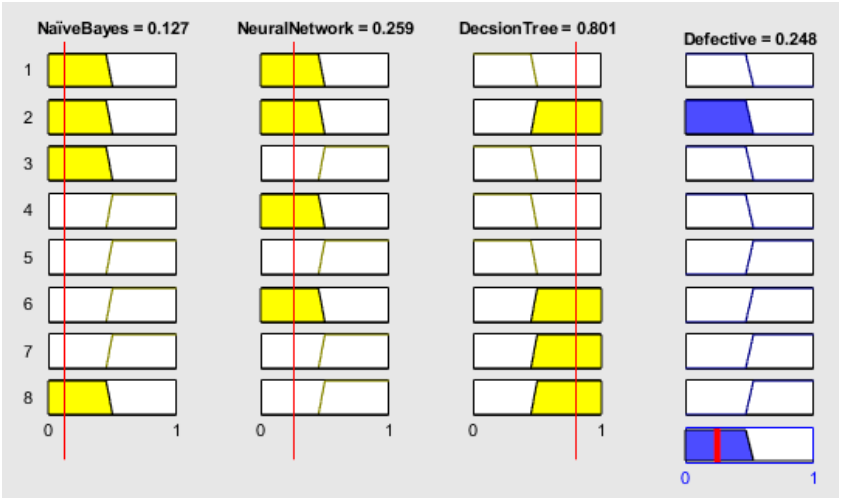
Figure 3. Results of the proposed fuzzy logic based fusion technique for a non-defective module (0).